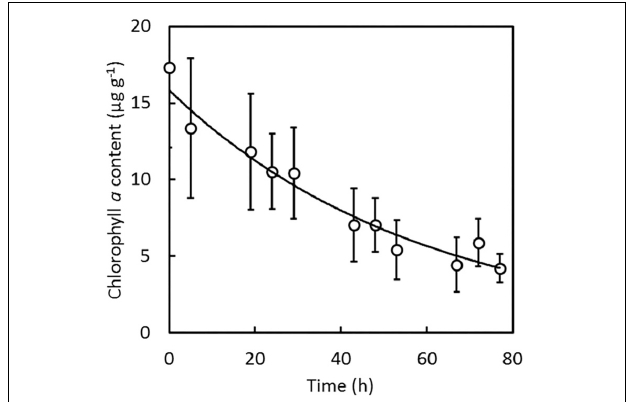
FIGURE 4 | Halichondria panicea . Wet-weight specific chlorophyll a content in sponge tissue after transfer from the field to bio-filtered seawater without phytoplankton. Data points show average values ± SD of 10 individual specimens. Regression curve is a first order decay with a rate constant of 0.017 h − 1 , r 2 =